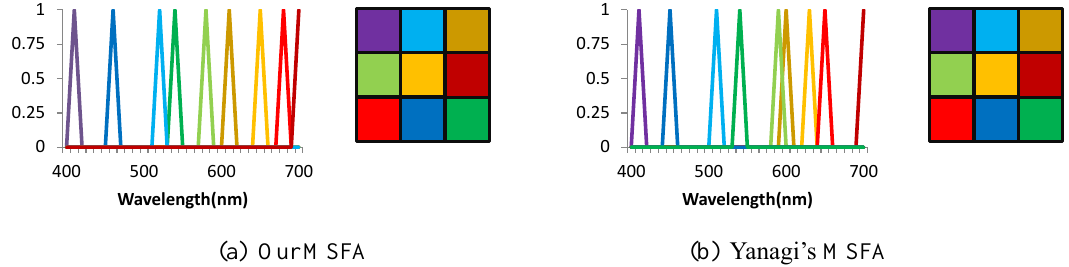
Figure 6. The spectral sensitivity functions and channel spatial arrangement of two MSFAs designed by Yanagi’s method and our method. Table 1. Quantitative evaluation of the reconstructions using Yanagi’s and our MSFA (see Figure 6) on synthetic datasets. Note that the bold font indicates the minimal error. Dataset MSFA